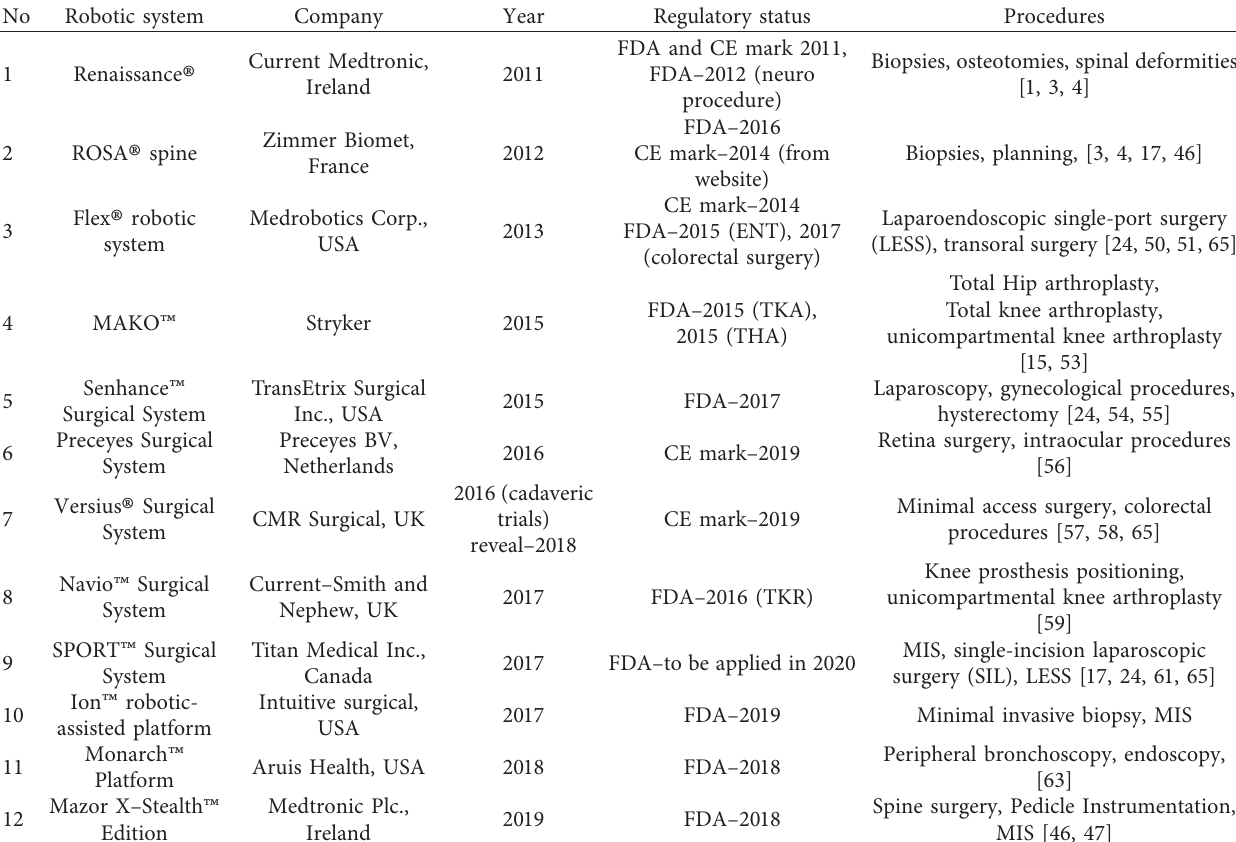
Table 3: Robotic systems that were developed in Decade III, from 2010 to 2020 (new